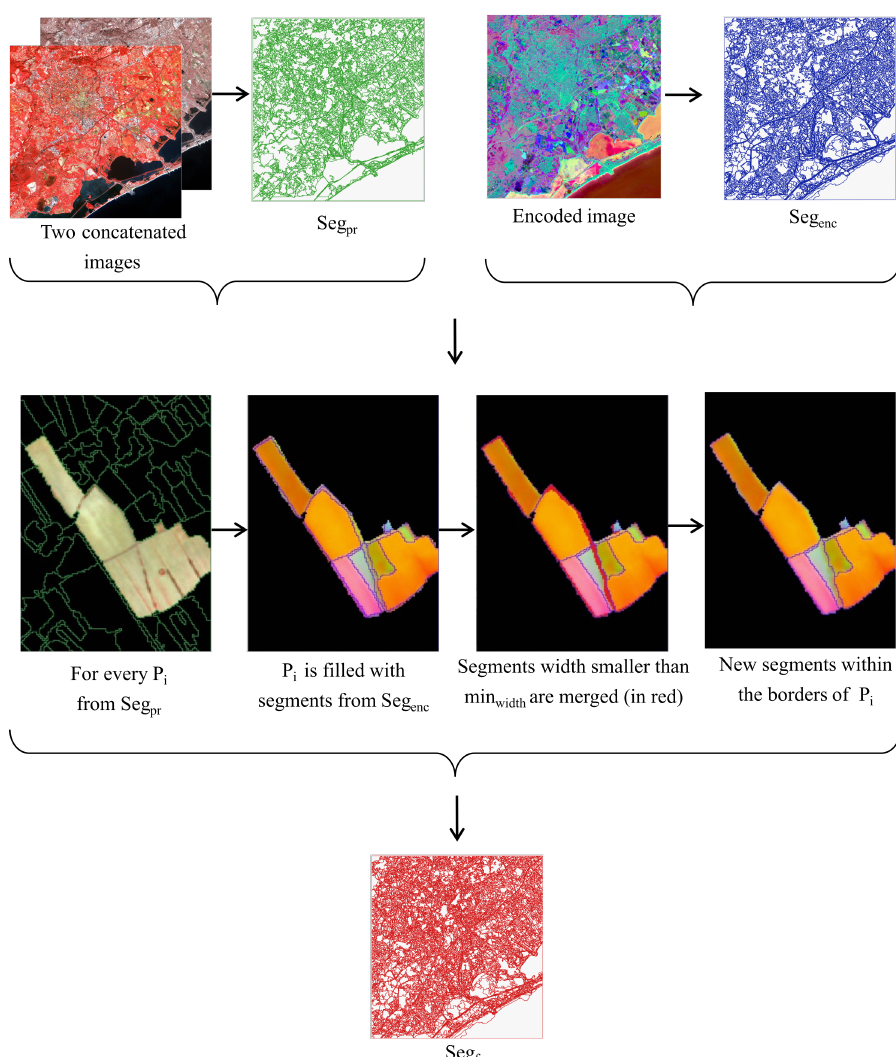
Figure 3. Segmentation